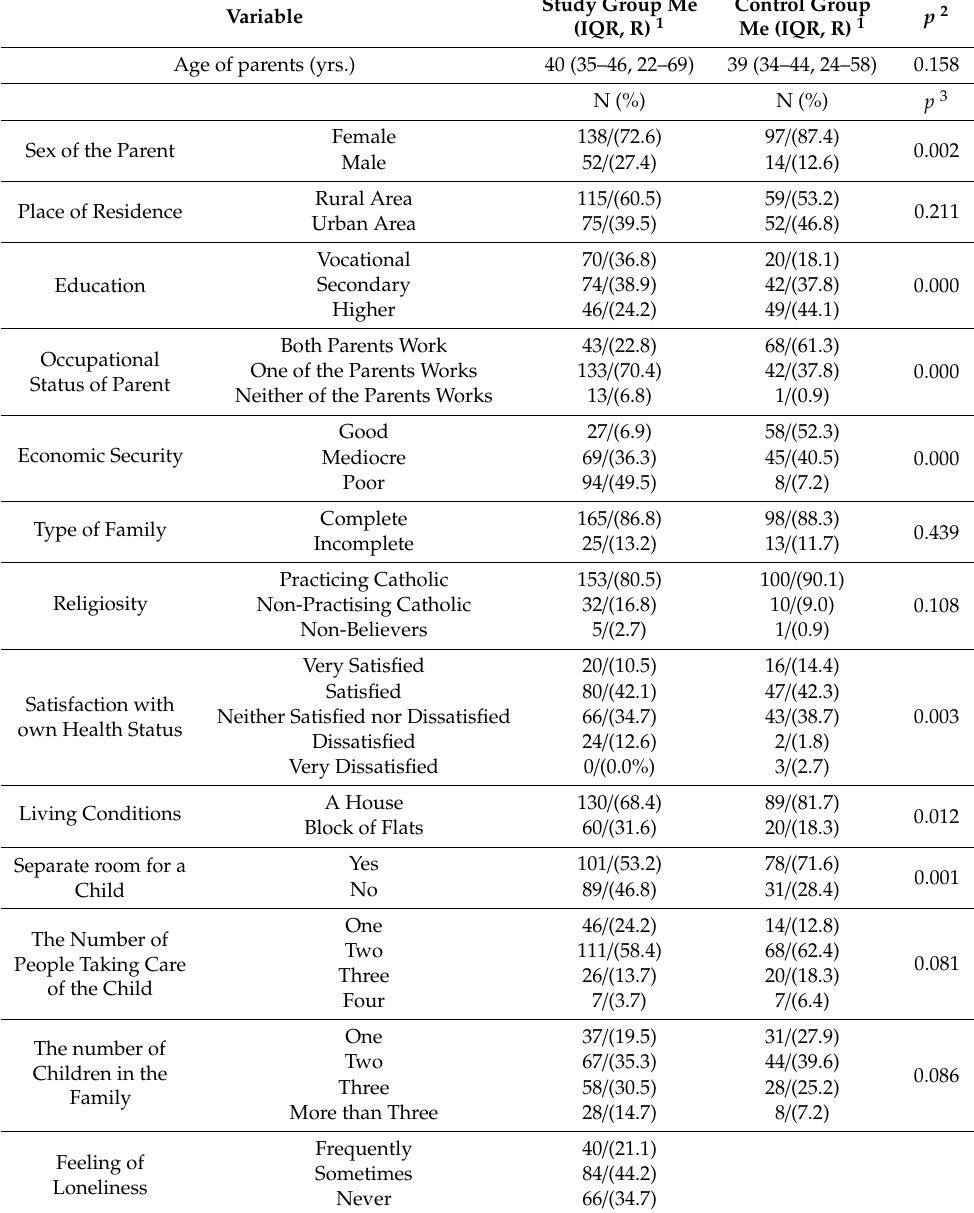
Table 1. Sociodemographic and family characteristics.